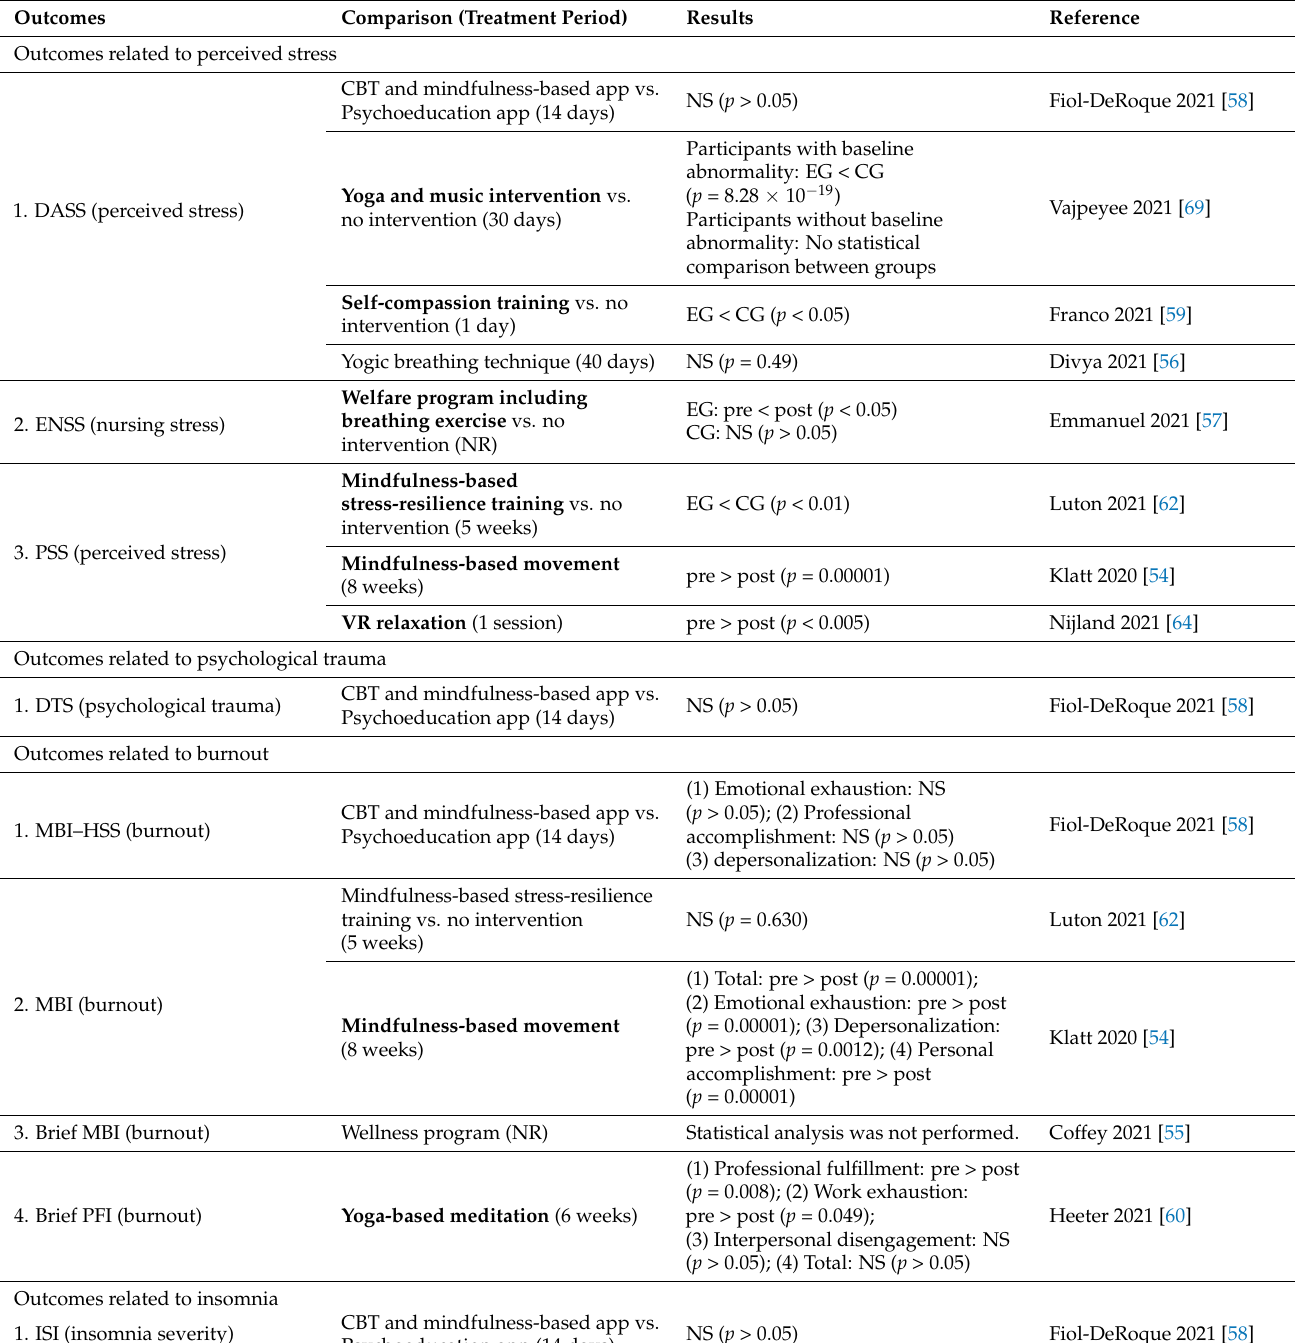
Table 2. Main results of included